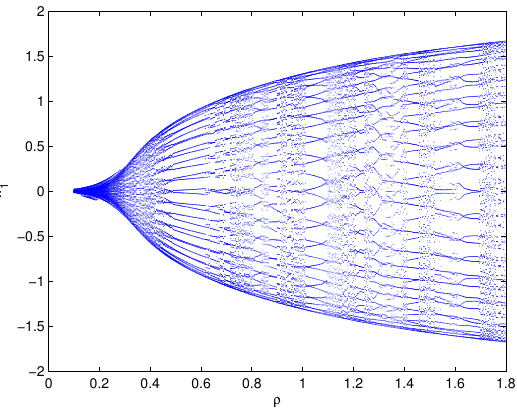
Figure 8. Bifurcation figure of system (96): ρ versus w 1 . The bifurcation value ρ (cid:63) ≈ 0.3.